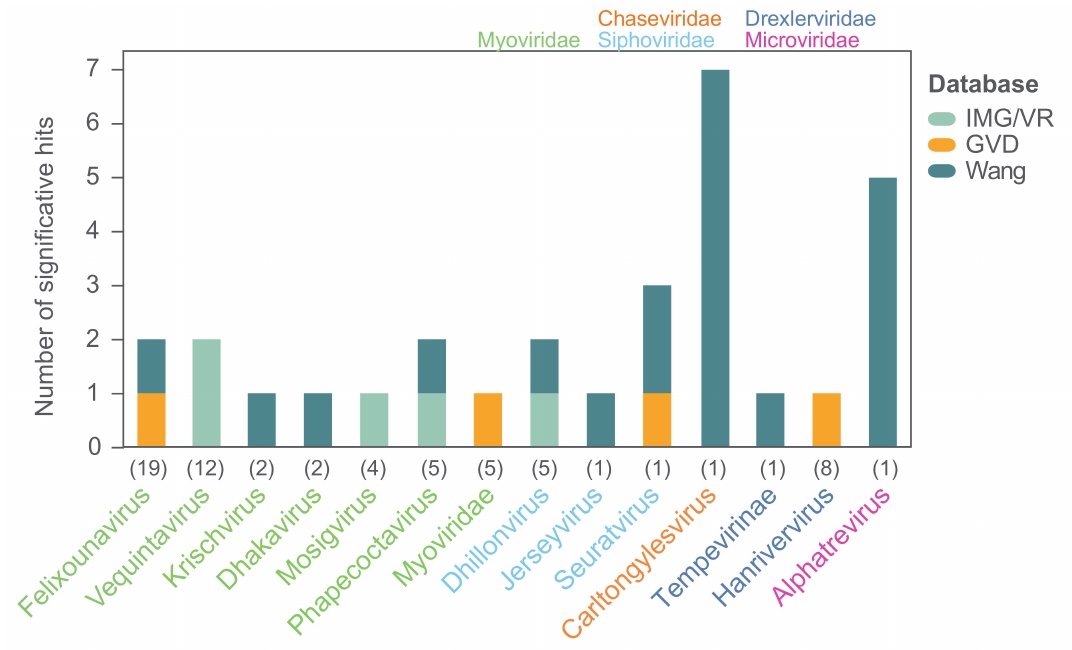
Figure 9. Significant hits for finding close relatives of the phages isolated in this study in three databases. Hits are defined as hits ≥ 80% genome coverage when blasting the coliphage genomes against the IMG / VR and GVD databases, and as mapped reads covering ≥ 70% of individual coliphage genomes when mapping reads from the Wang study. The coliphages are grouped according to genera, and numbers in parentheses denote the number of coliphage species representing each genus; only genera with significant hits are shown. Color-codes of genera denote taxonomic